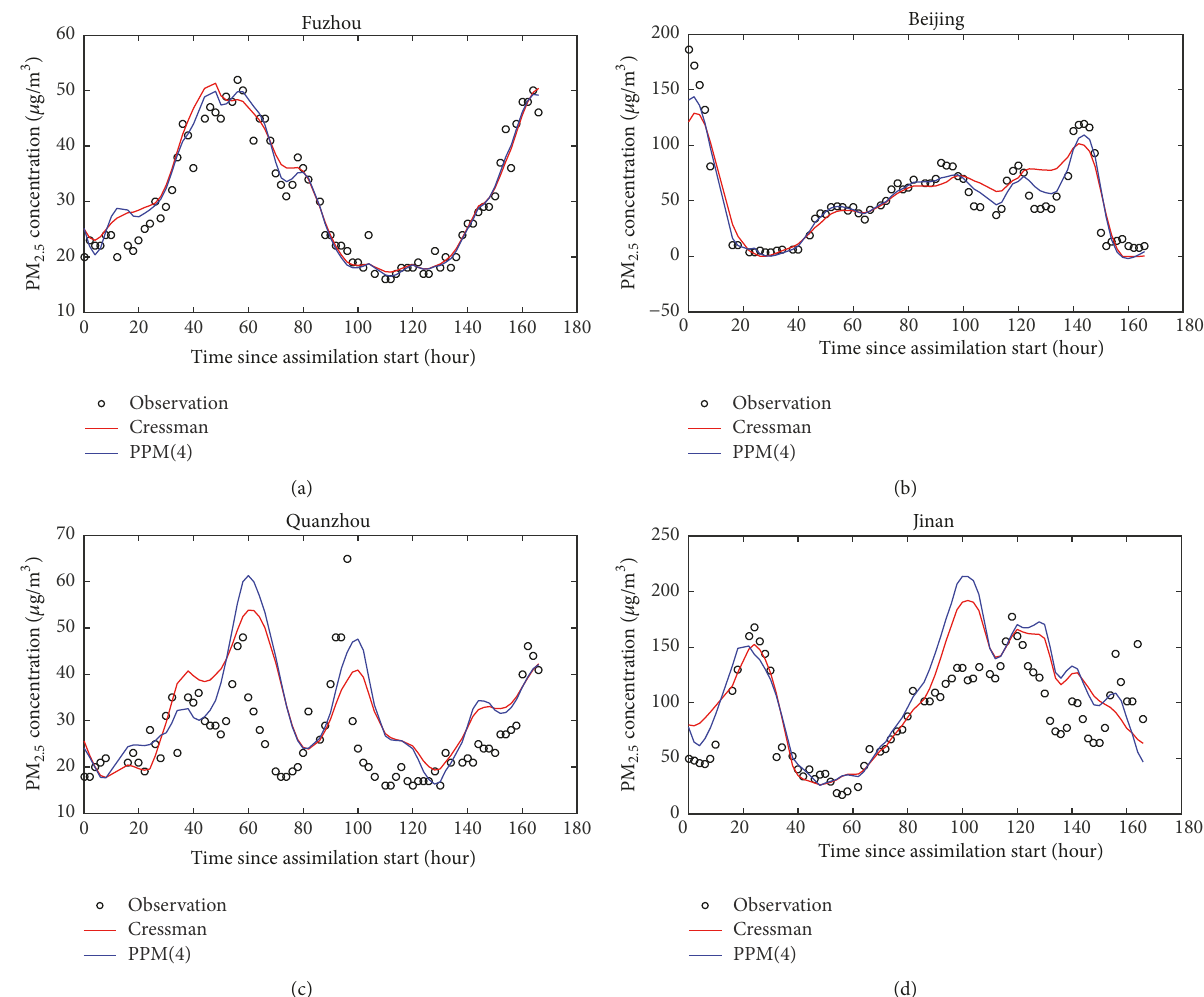
Figure 5: The time-varying PM 2.5 concentrations of four representative cities during the assimilation